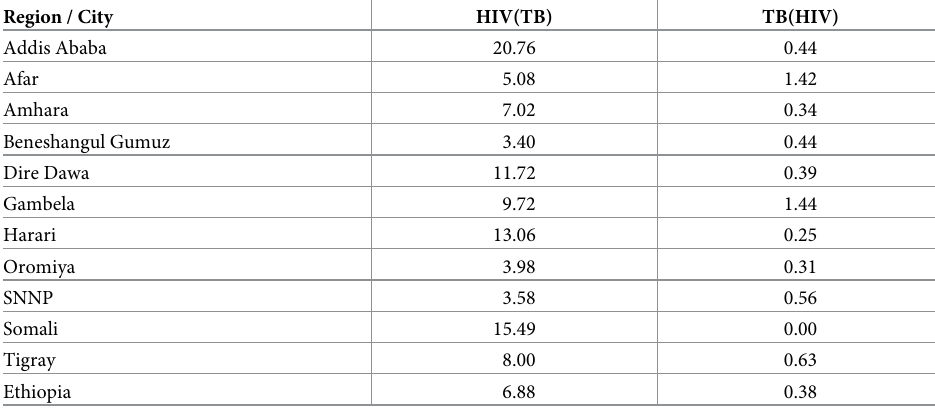
Table 2. The prevalence of HIV among TB patients (HIV(TB)) and the prevalence of TB among PLHIV (TB (HIV)) by regions. Region /